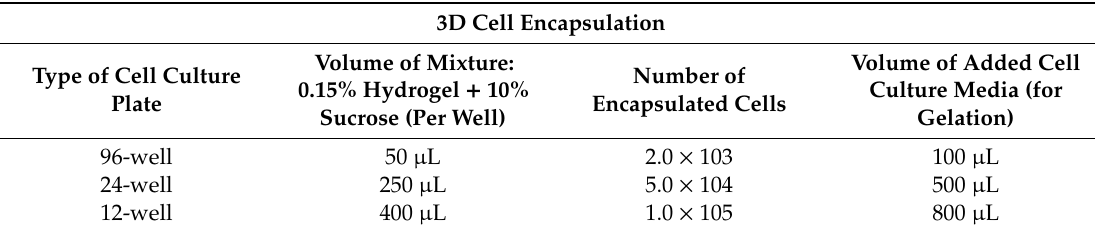
Table 2. Preparing of 3D encapsulation of DPSCs within the hydrogel matrix. 3D Cell